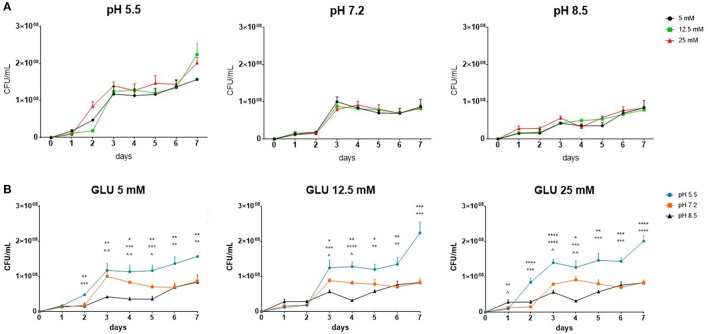
Kinetics of biofilm formation by Myroides odoratimimus in collagen gel matrix. Biofilm viability was assessed, by viable cell count, in SWF at different pH values (5.5, 7.2 and 8.5) and glucose concentrations (5, 12.5 and 25 mM) during a 7 day-incubation at 37°C. Results are shown as mean values + SDs (n = 6). Regression linear analysis showed a significant positive trend, regardless of pH and glucose concentration considered. Kinetics are stratified on (A) pH value or (B) glucose concentration. The number of symbols (*pH 5.5 vs. pH 7.2; °pH 5.5 vs. pH 8.5; ∧pH 7.2 vs. pH 8) indicates significance levels at ANOVA + Tukey's multiple comparison post-test: 1 (p < 0.05), 2 (p < 0.01), 3 (p < 0.001), and 4 (p < 0.0001).